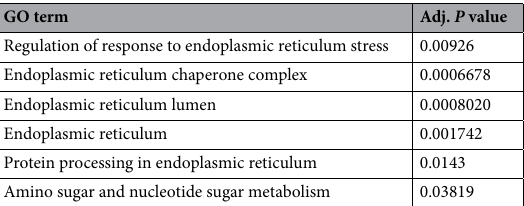
Table 5. Enriched GO functions in hepatic tissue from bulls divergent for RFI.